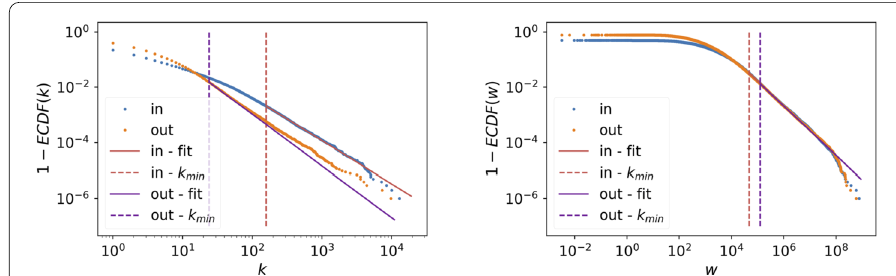
Figure 1 Empirical complementary cumulative degree (left) and strength (right) distributions and their power law fit. The scale is logarithmic for both axes. Data refers to